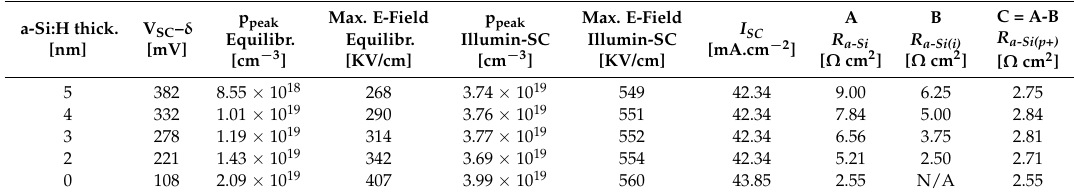
Figure 8. Simulated I-V characteristics under illumination for cell SHJ 1 with thermionic emission transport for different values of the Richardson constant A * . The I-V characteristics assuming drift-diffusion (Curve 5) is also plotted for comparison. Table 4. Enhanced cell resistance in cell SHJ 1 versus a-Si:H(i) thickness.